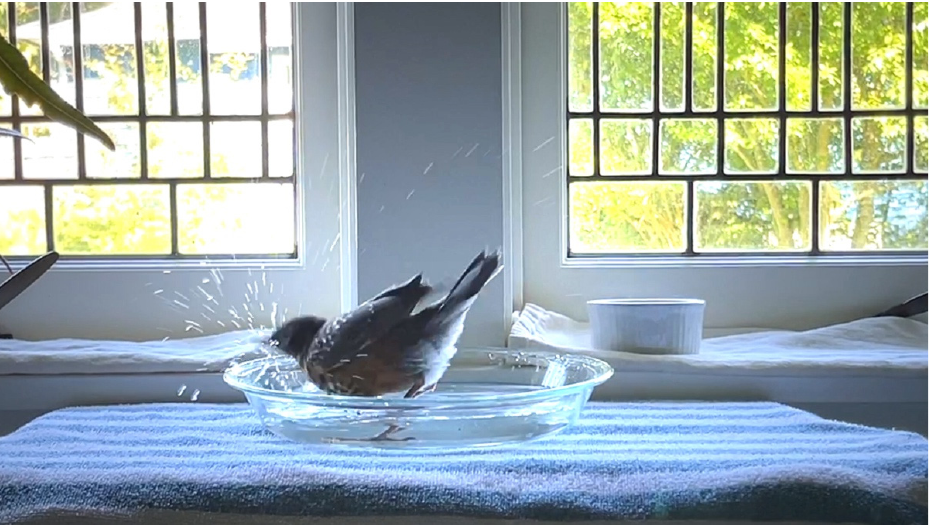
Figure 7. Like The Air (2022). Digital film still. https://vimeo.com/showcase/9841426/video/752712549 (accessed on 26 September 2022).